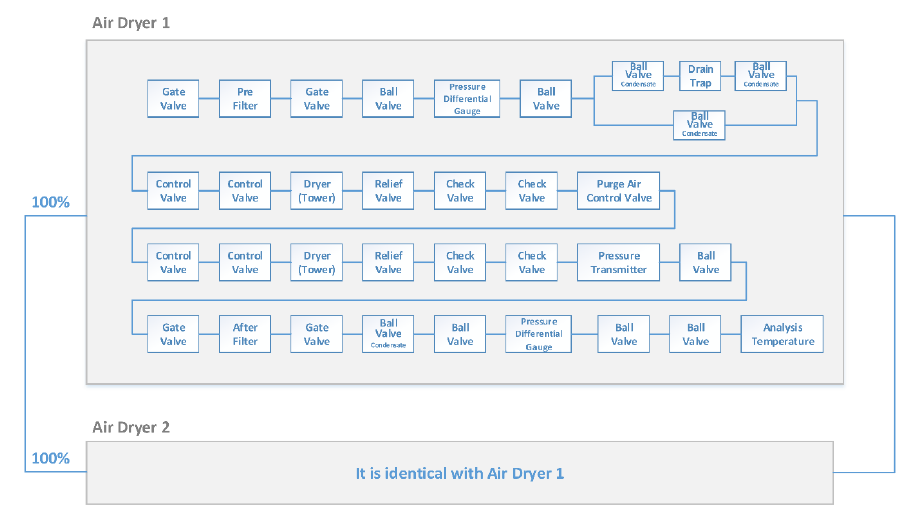
Figure 9. Reliability block diagram at Stage II (preliminary P&ID stage)—Air dryer part.